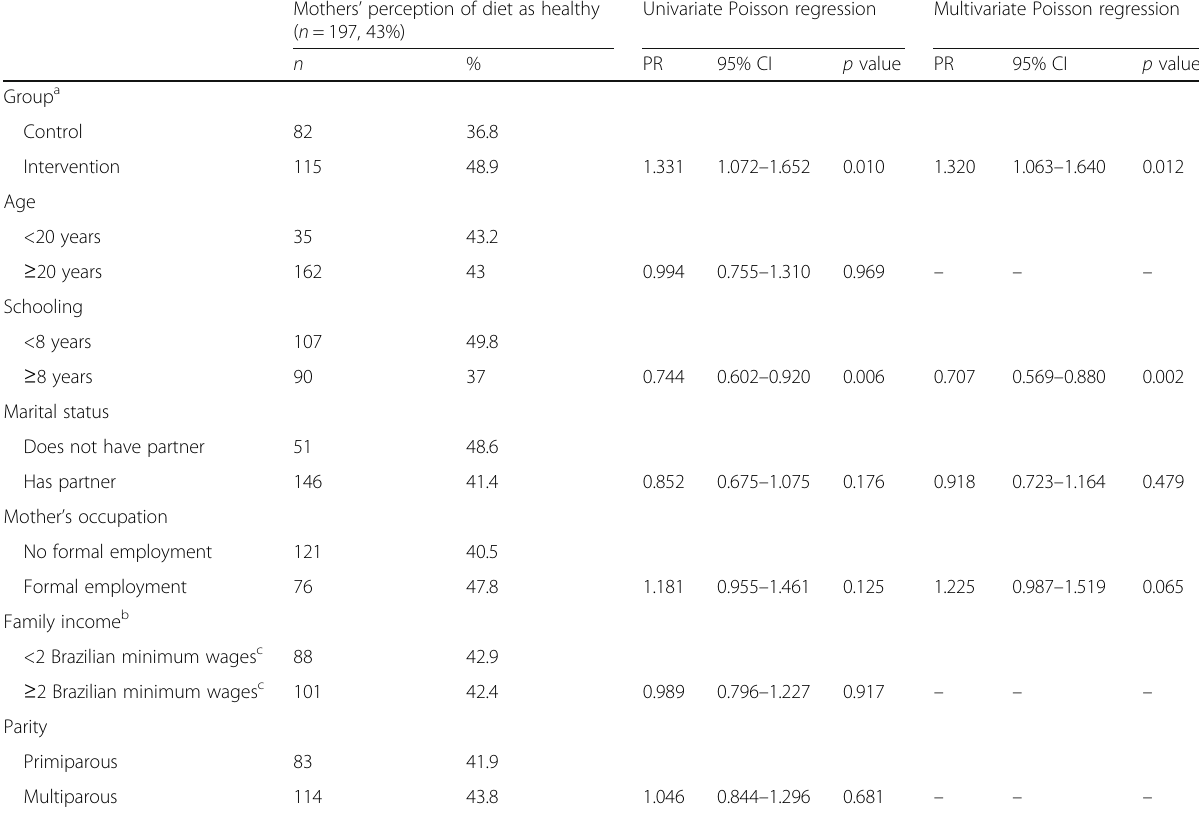
Table 3 Association between mothers ’ perception of their own diets and personal and family characteristics ( n =